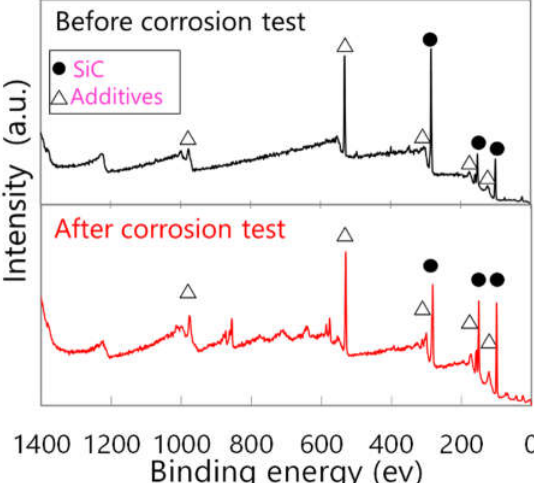
Figure 9. XPS spectrum of the modified LPS before and following high-temperature water corrosion (2 ppm dissolved oxygen, 20 MPa, 320 °C, and 168 h).